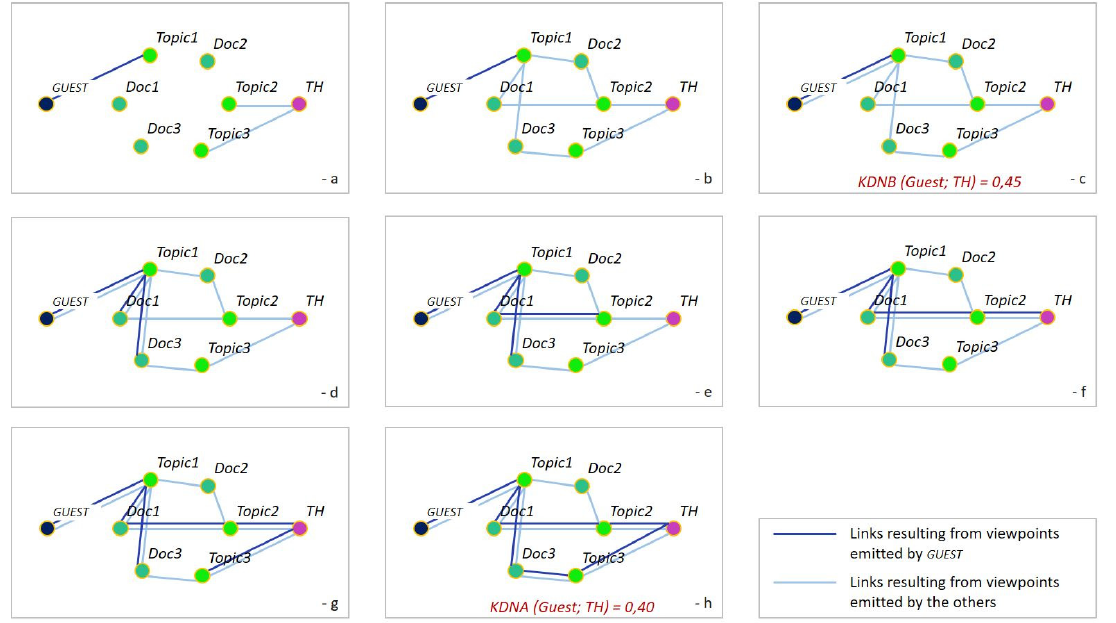
Figure 17. An imaginary case illustrating how trails opened by others progressively connect a guest to a topic hub.